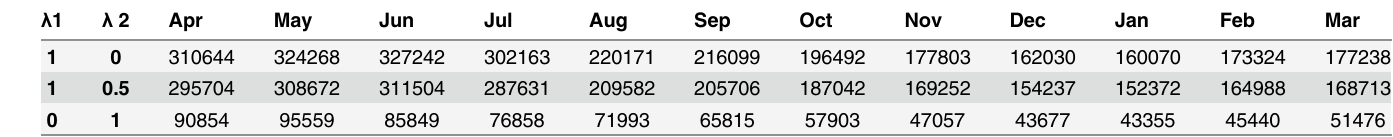
Table 4. The average results of hydroelectric power generation of Karun 1 using weighting method (MWh).